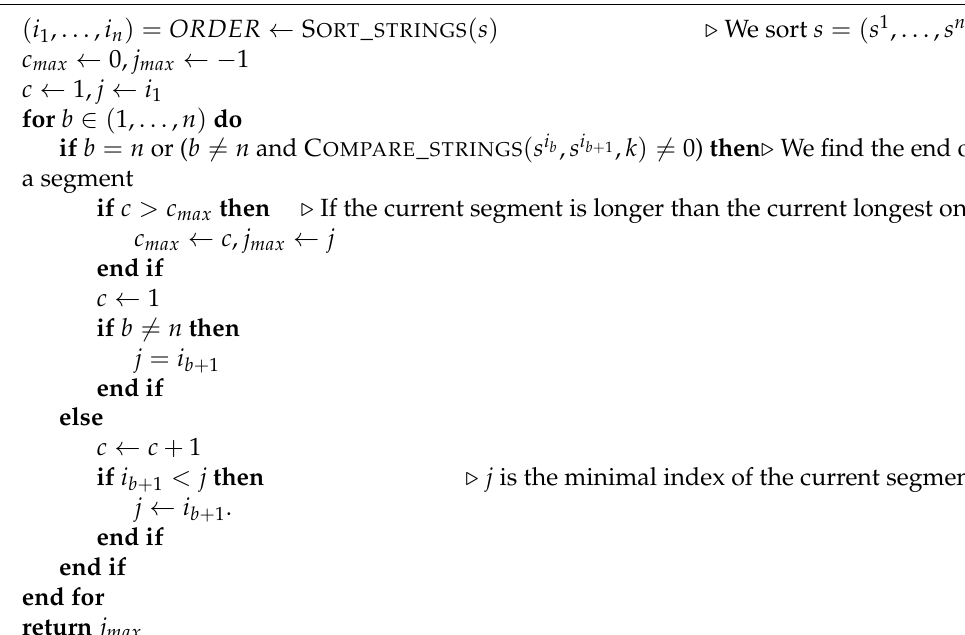
Algorithm 2 The Quantum Algorithm for the Most Frequent String